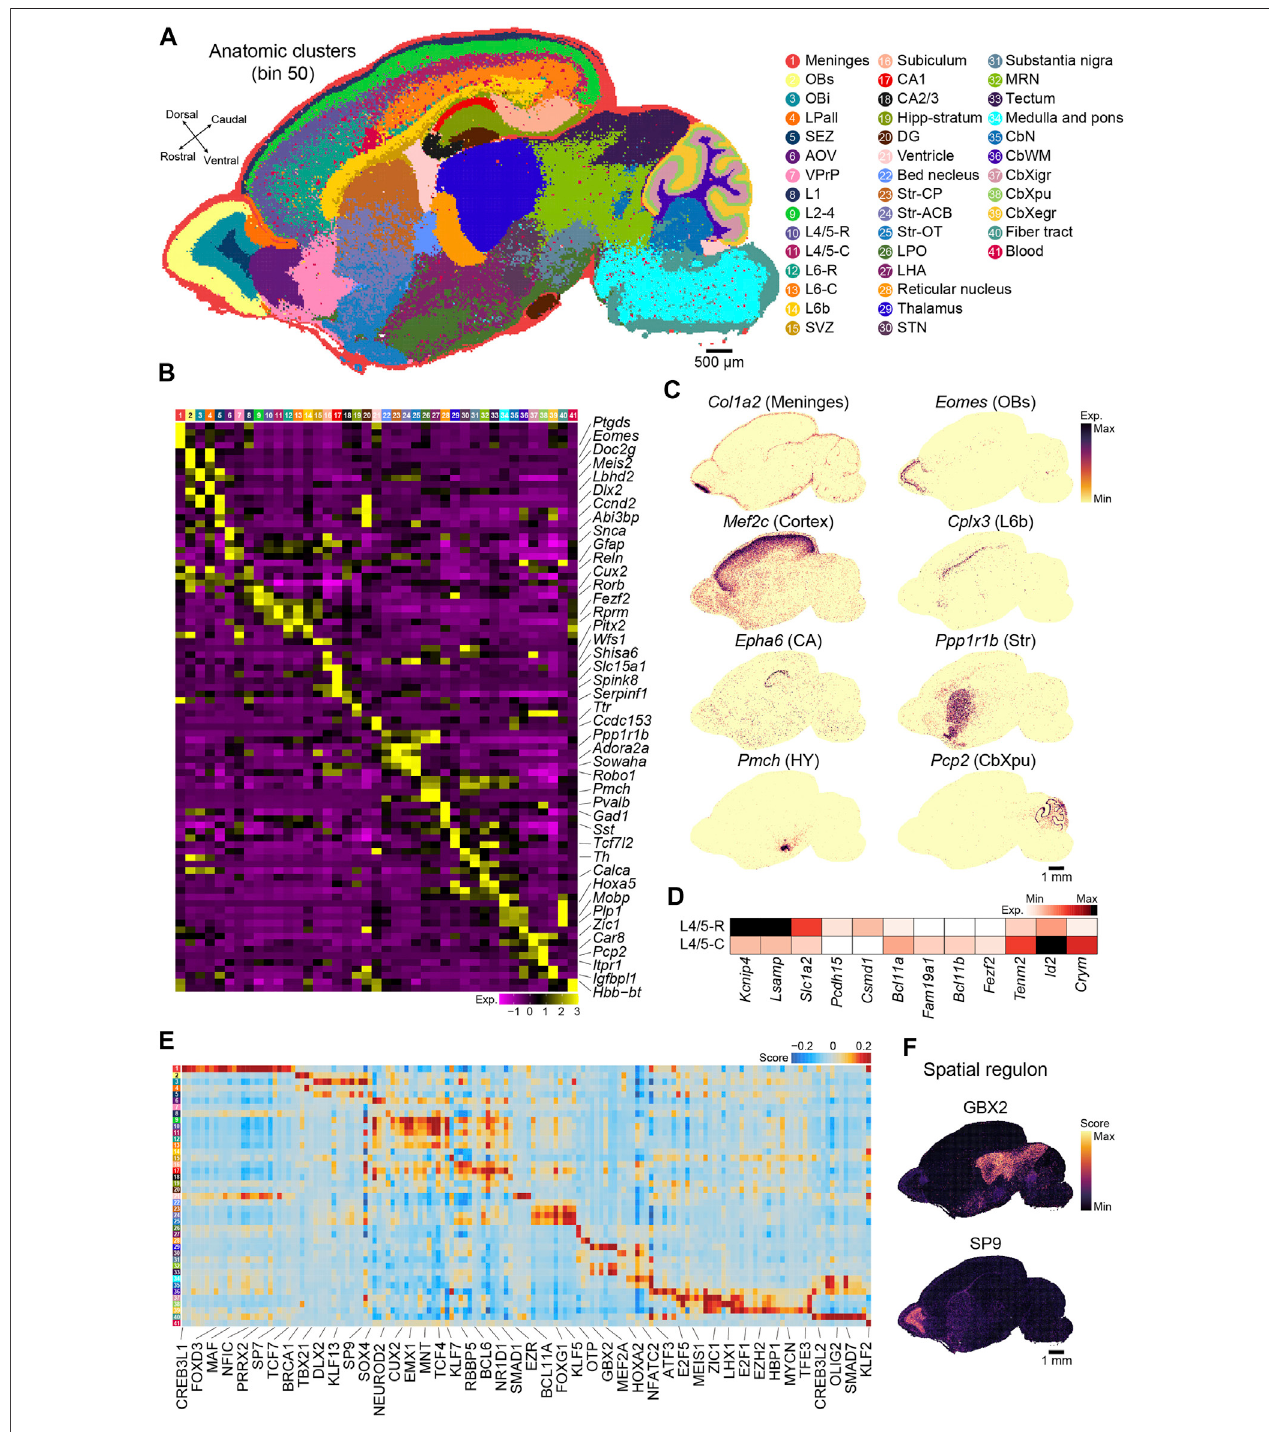
FIGURE 2 | Recognition of regional and molecular characteristics of the anatomical regions based on binning. (A) Unsupervised spatially constrained clustering of the P7 mouse brain sagittal section 1 analyzed by Stereo-seq at bin 50 resolution. Bins are colored by their annotation. OBs, super fi cial stratum of olfactory bulb; OBi, intermediate stratum of olfactory bulb; LPall, lateral pallium; SEZ, subependymal zone; AOV, anterior olfactory nucleus; VPrP, ventropallial prepiriform area; L1, cortical layer1; L2 – 4, cortical layers 2 – 4;L4/5-R, cortical rostral layer 4/5;L4/5-C, cortical caudal layer 4/5; L6-R, cortical rostral layer 6; L6-C, cortical caudal layer 6; L6b, cortex layer 6b; SVZ, subventricular zone; CA1, cornu ammonis area 1; CA2/3, cornu ammonis area 2/3; Hipp-stratum, stratum molecular of CA and DG; DG, dentate gyrus; Str-CP, caudoputamen; Str-ACB, nucleus accumbens; Str-OT, olfactory tubercle; LPO, lateral preoptic area; LHA, lateral hypothalamus; STN, subthalamic